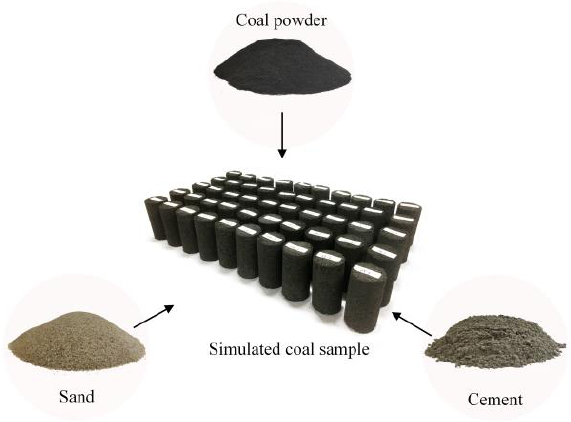
Figure 4. Preparation of simulated coal sample.